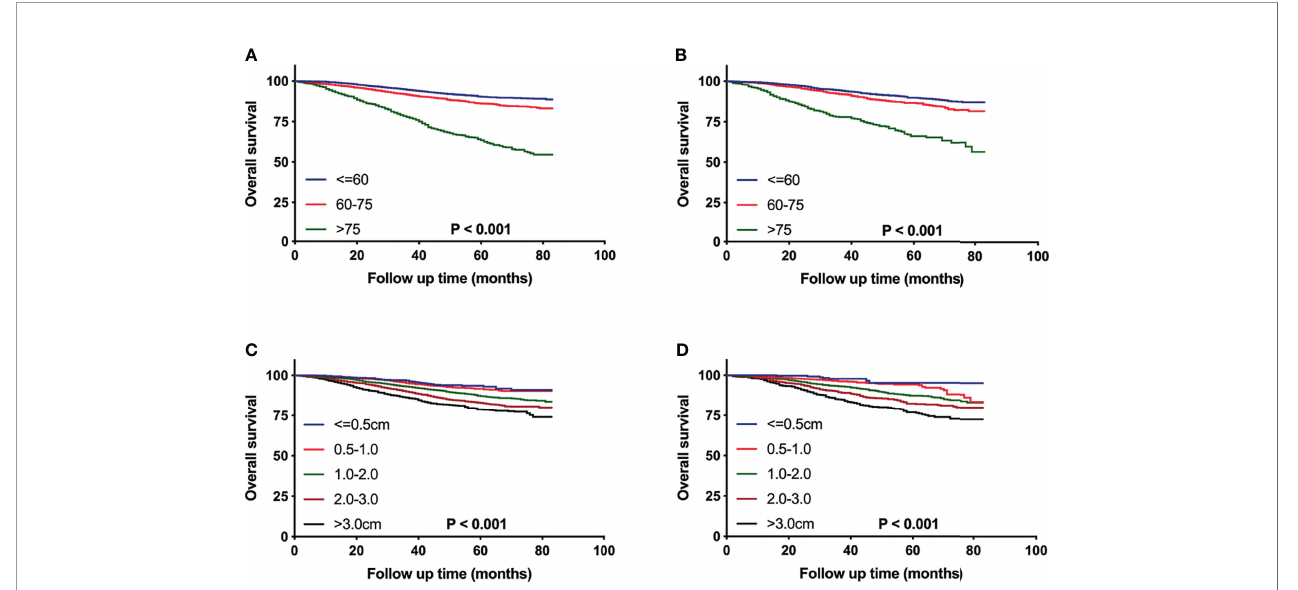
FIGURE 2 | Kaplan – Meier curves comparing OS for pT1-2N0M0 TNBC patients strati fi ed by the cutoff values of age (A, B) or tumor size (C, D) in the training cohort (A, C) and the validation cohort (B, D) ,